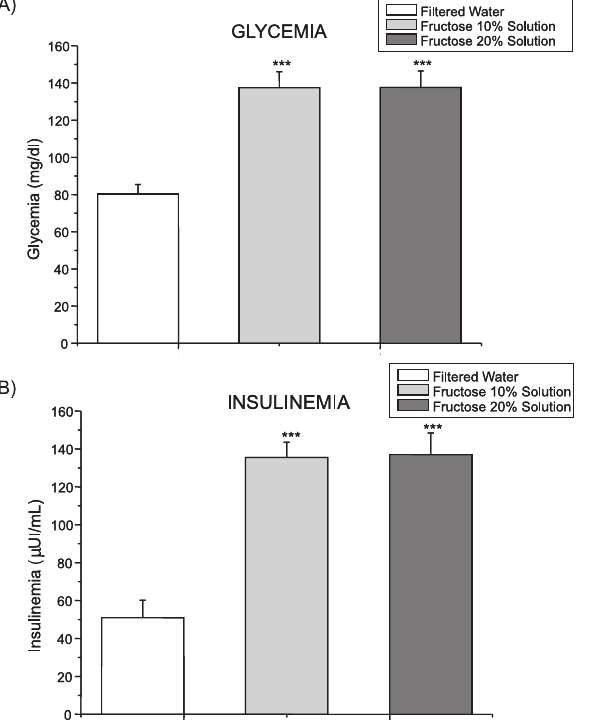
Figure 2 - Effects on glycemia (a) and insulinemia (b) of filtered water, 10% fructose solution, or 20% fructose solution on animals treated for 4 months. Results expressed as mean ± SEM; *** = P < .001 compared to controls.